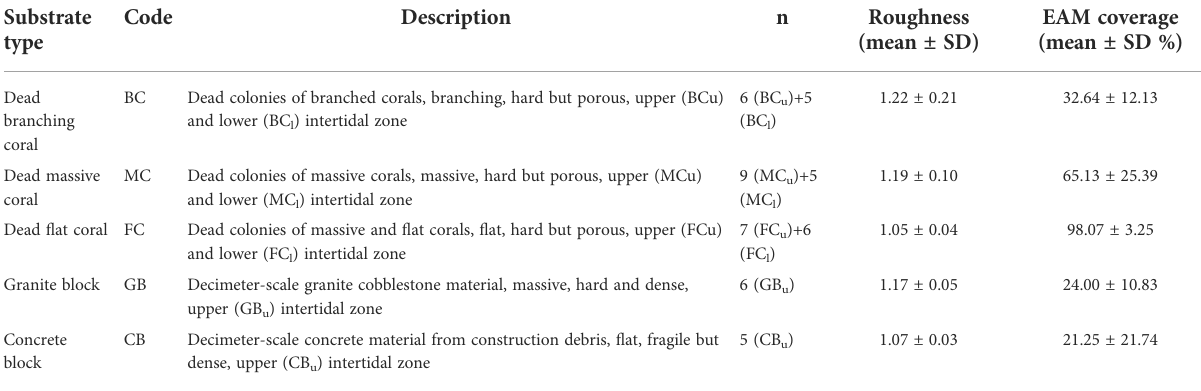
TABLE 1 Classi fi cation and characteristics of the fi ve studied substrates (Subscripts after substrate code are used to distinguish different tidal levels, with u and l representing the upper and lower intertidal zones respectively). Substrate